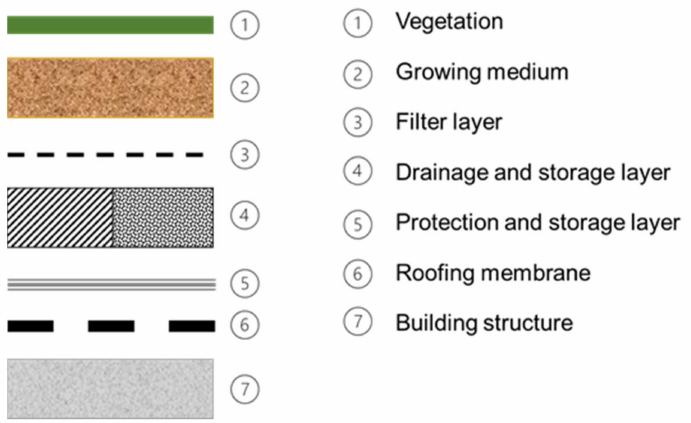
Figure 2. General structure of green